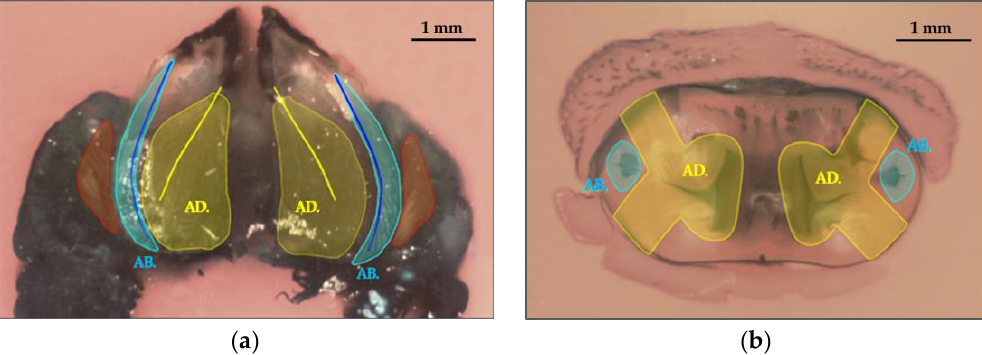
Figure 6. Optical micrographs: ( a ) longitudinal and ( b ) cross-section of the cephalic capsule and prothorax. The adductor muscles (AD) are highlighted in yellow, the abductor muscles (AB) are highlighted in light blue, and the exit and entrance muscles of the cephalic capsule are highlighted in orange.